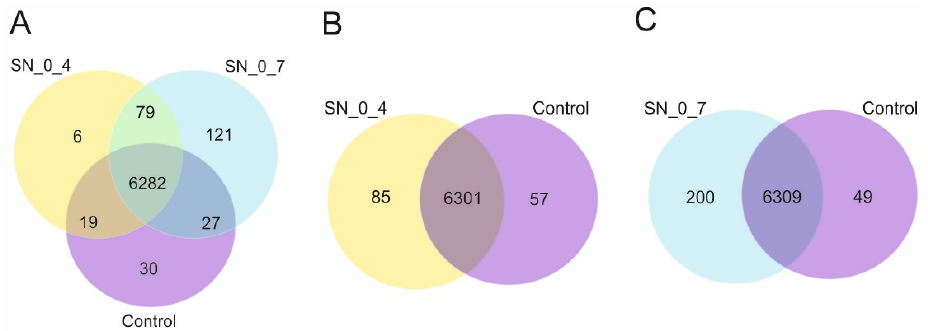
Figure 4. Venn diagrams of coexpression analysis ( A – C ). Numbers in colored circles presents number of genes uniquely or coexpressed in three samples. SN_0_4: cells incubated in supernatant derived from treatment with 0.4% peroxide; SN_0_7 cells incubated in supernatant derived from treatment with 0.7% peroxide; Control: cells incubated in diluted rich medium. Figures are provided by Novogene Co Ltd. and modified.